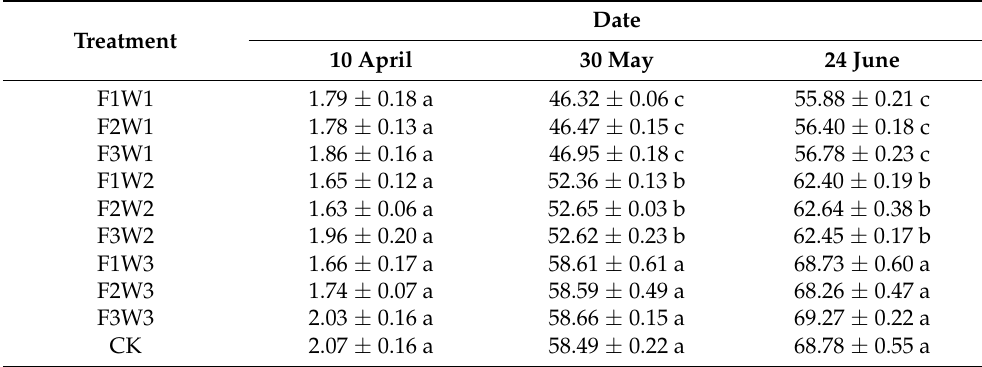
Table 3. Growth of new shoots (mm) of fragrant pear under different treatments.